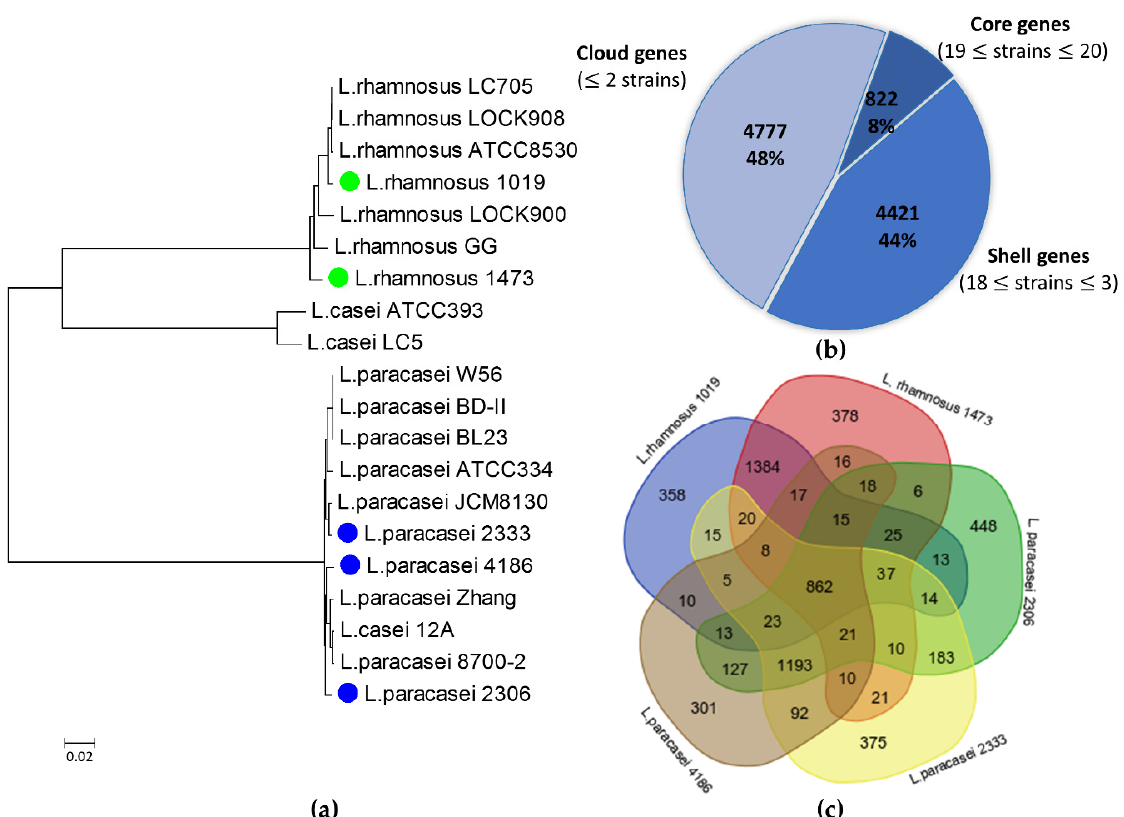
Figure 2. Phylogenetic analysis of Lacticaseibacillus isolates: ( a ) phylogenetic tree constructed by using newly sequenced strains and 15 reference strains, as inferred from core gene sequence alignment. Sequences were aligned using Roary, RAxML was used to construct a maximum-likelihood phylogenetic tree; ( b ) description of the pan genome of the 20 strains belonging to Lacticaseibacillus genus; ( c ) Venn diagram showing the number of shared and unique genes among the newly sequenced strains of Lacticaseibacillus genus.